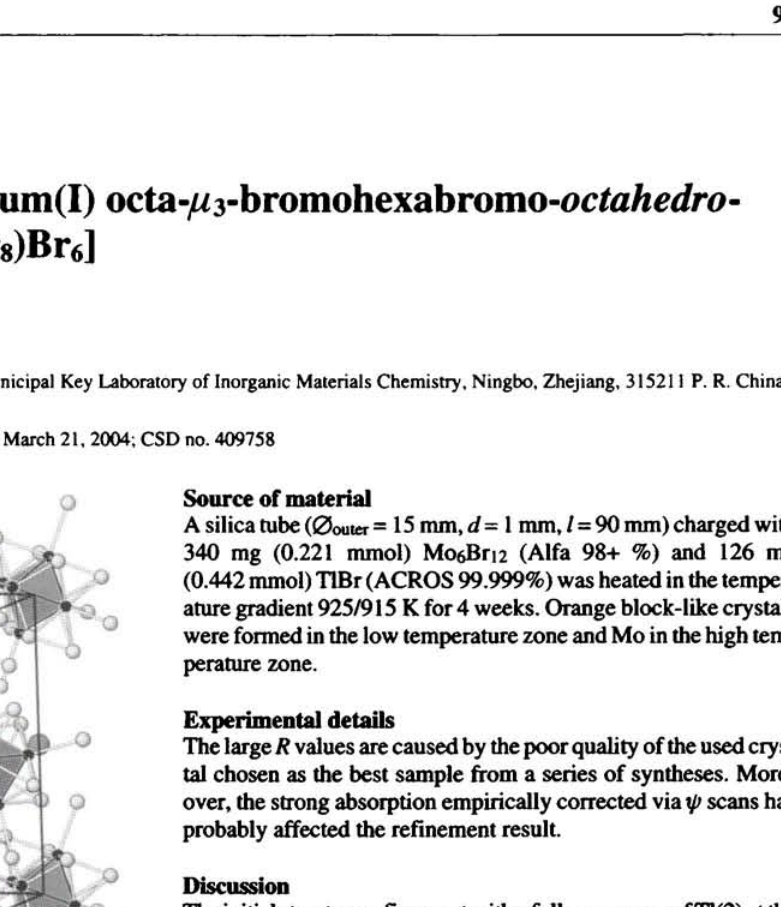
Table 1. Data collection and handling.